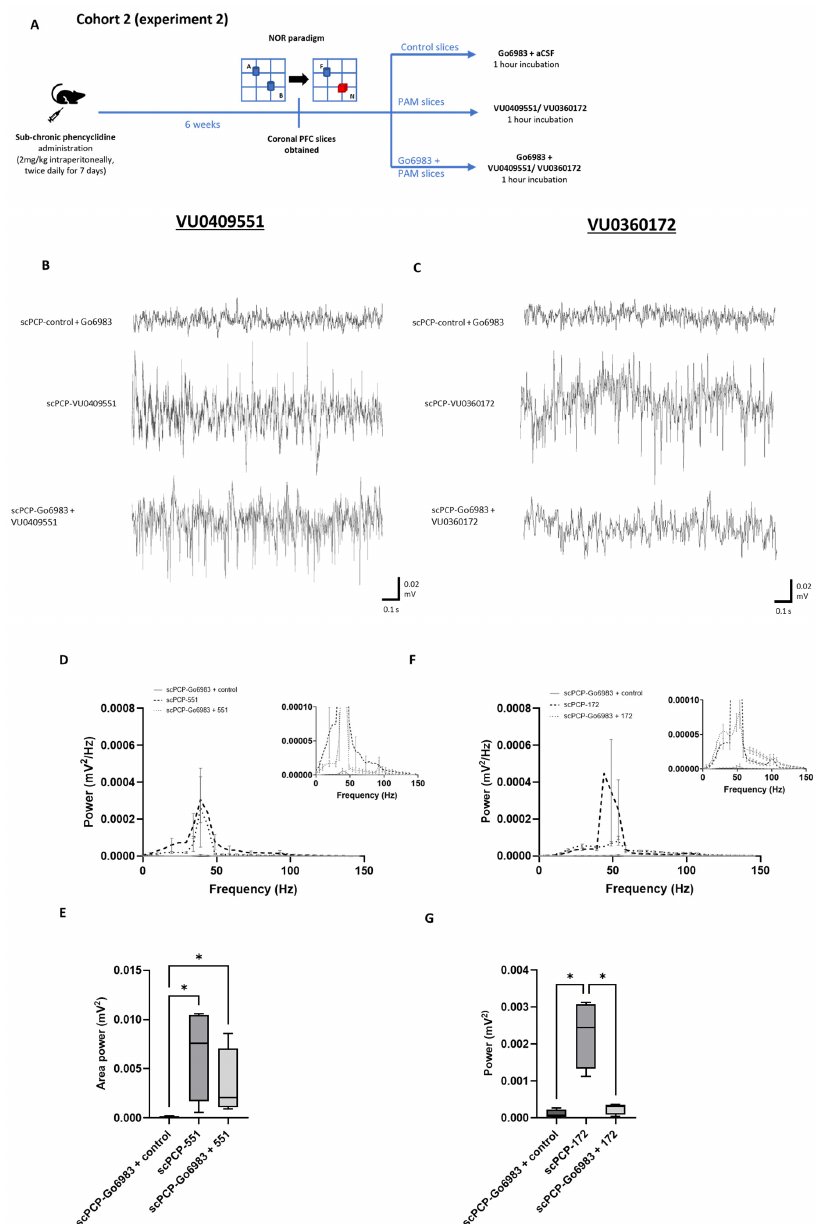
Figure 6. Go6983 (10 nM) had differential effects on the activity of VU0409551 or VU0360172 in scPCP slices in terms of gamma power. ( A ) Schematic illustrating the experimental protocol for Cohort 2, experiment 2. A, B, blue; identical objects. F, blue; familiar object. N, red; novel object. ( B , C ) Representative traces showing oscillatory activity in PFC slices from scPCP-treated rats without PAM application with Go6983 alone (scPCP-control + Go6983), and scPCP slices treated with Go6983 followed by VU0409551 or VU0360172. The Go6983 was present during PAM incubation but was washed off before oscillations were evoked. Power spectral analyses show the effect of Go6983 alongside ( D ), VU0409551, and ( F ), VU0360172 on amplitude power ( n = 4 per group, analysed using a Friedman’s test followed by Dunn’s tests). Graph insets more clearly illustrate data in low power ranges. Box plots show the median (whiskers max–min) area power in slices incubated in ( E ), VU0409551 ( n = 4 per group) or ( G ), VU0360172 ( n = 4 per group; both analysed using Friedman’s tests followed by Dunn’s tests; * p < 0.05, significant increase in area power in with PAM incubation or Go6983 + VU0409551 incubation relative to control; * p < 0.05, significant decrease in area power following Go6983 + VU0360172 incubation relative to VU0360172